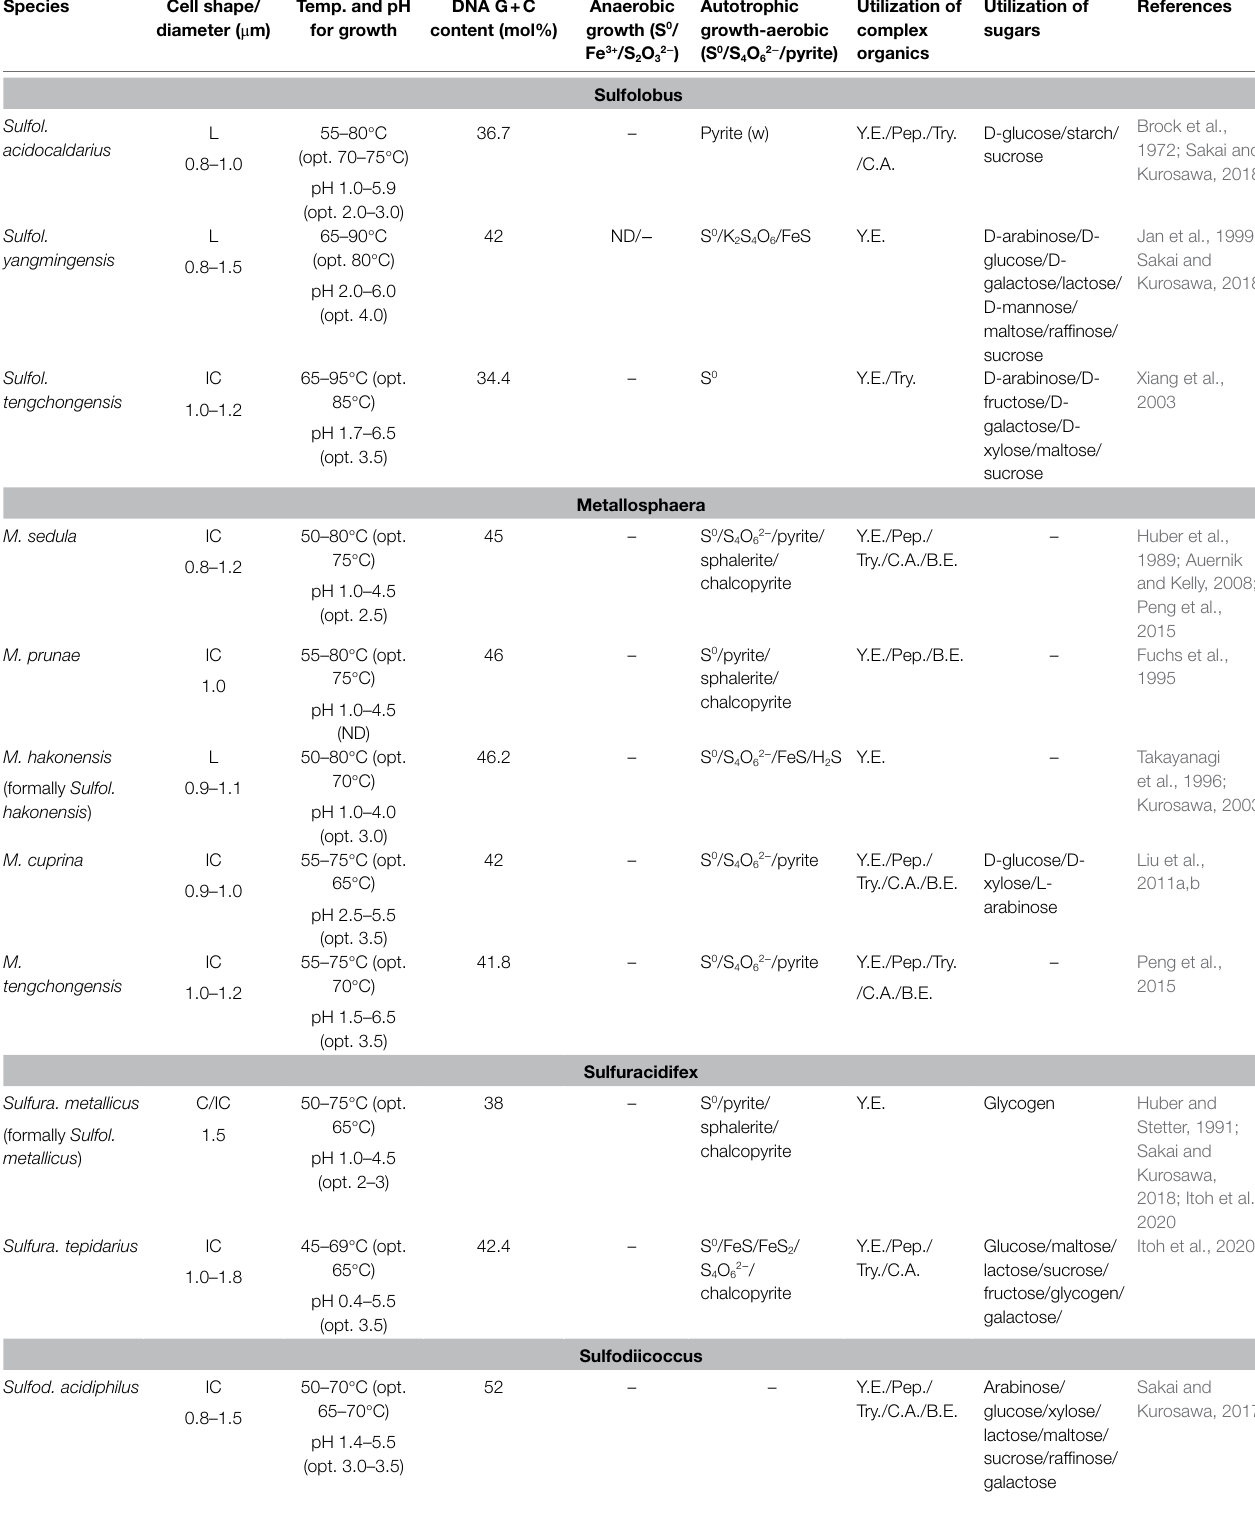
TABLE 2 | Characteristics of the main members in Sulfolobales.